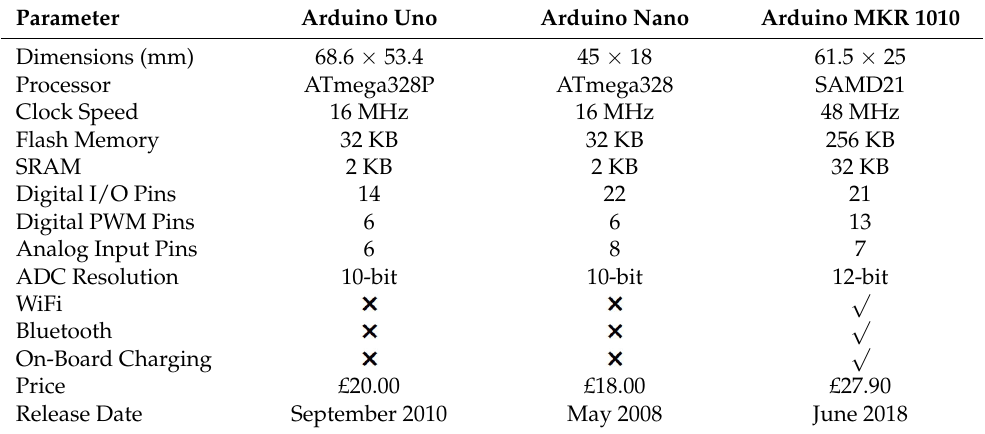
√ means that the feature is available, while means that